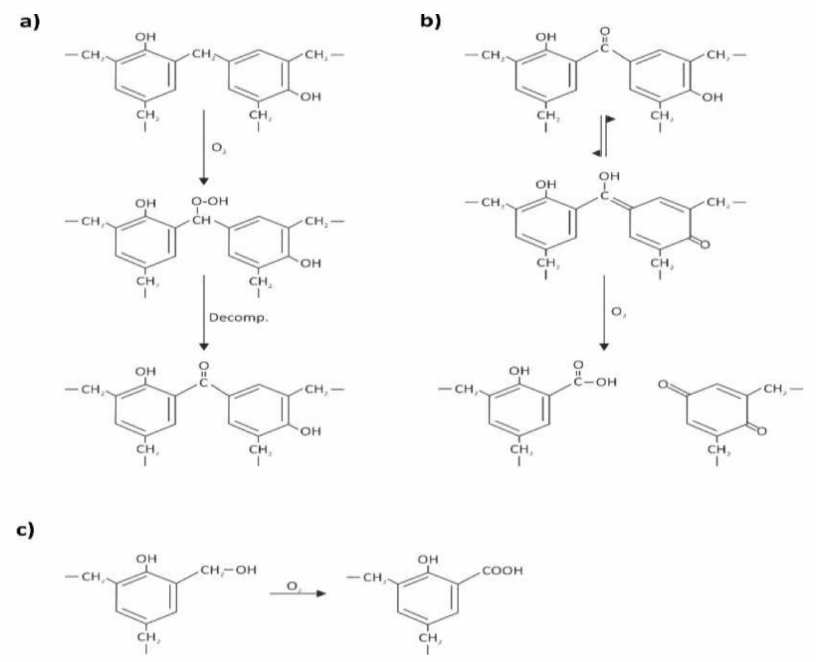
Figure 14. Mechanisms of oxidation reactions on phenol formaldehyde (PF) after Conley [13]: ( a ) primary photo-oxidation reactions: oxidation at a methylene linkage resulting in the formation of carbonyl groups; ( b ) secondary photo-oxidation reactions: formation of quinone-type structures; and ( c ) oxidation of methylol groups and formation of acidic